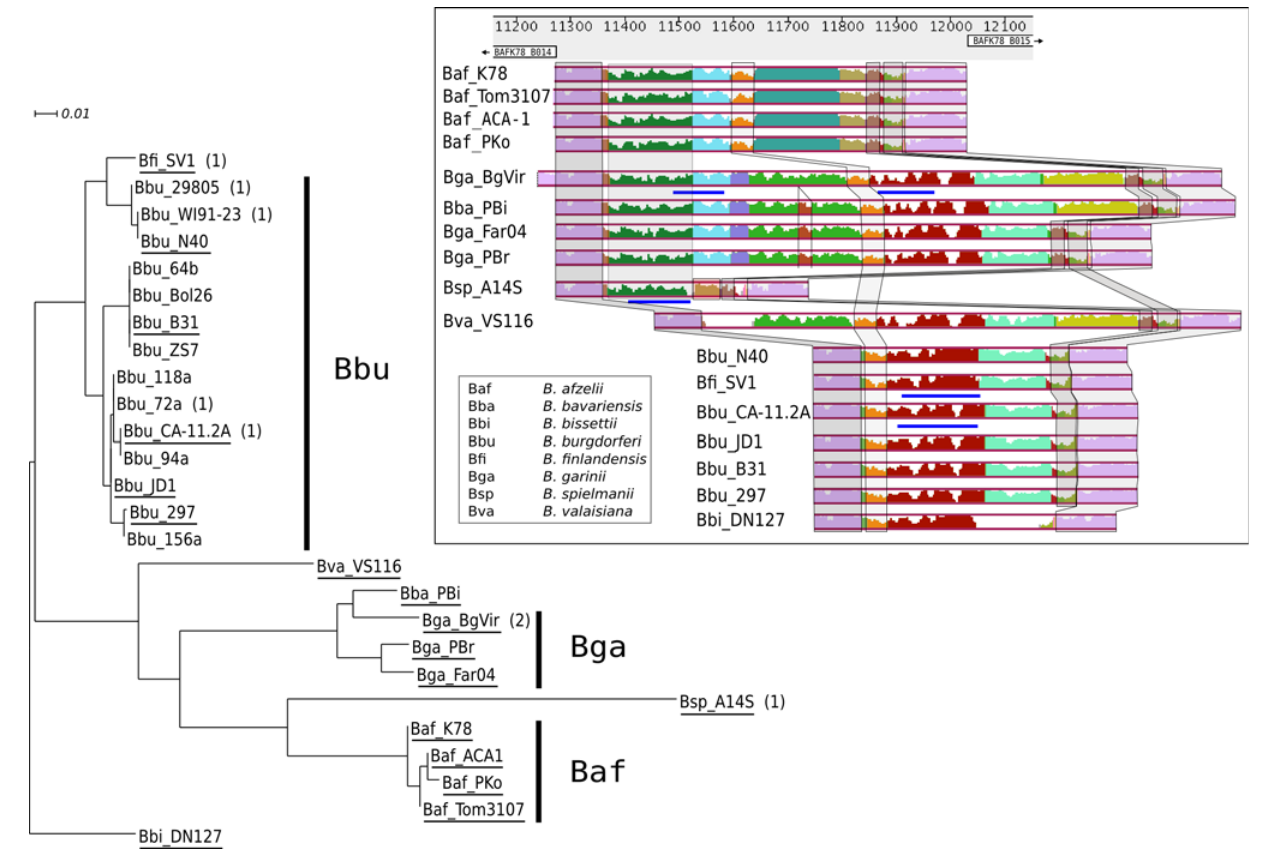
Fig 4. Species-specific variation of the intergenic variable region in the circular plasmid cp26. The variable sequence segment in the cp26 plasmids of K78 is compared with 25 Borrelia strains. A maximum likelihood tree rooted with a B . bissettii sequence as outgroup, shows the relationship for the intergenic part, which in B . afzelii K78 is situated between BAFK78_A0014 and BAFK78_A0015 (bacterial extracellular solute-binding protein), and which shows a species-specific length. Insertions and deletions within this region have been analyzed with the program Mauve, and the compositional analysis for 16 of the 26 sequences (underlined in the tree view) is shown with related segments marked by color and/or boxes together with a similarity score diagram for each sequence. Blue bars denote segments which, in some strains, have been annotated as short hypothetical proteins (the number of assigned proteins in this region is indicated in parentheses in the tree